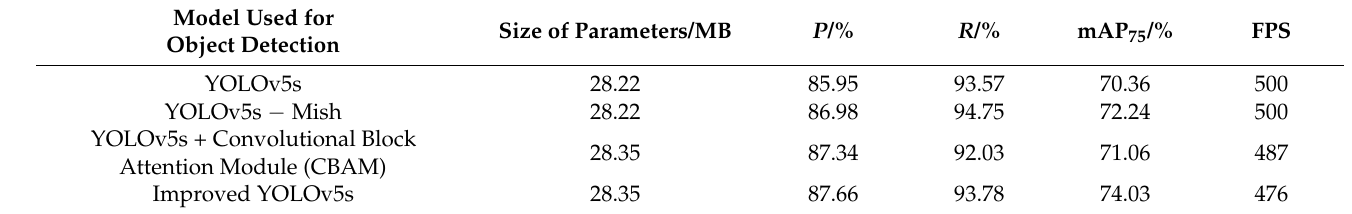
Table 5. Performance comparison between different versions of YOLOv5s in detecting